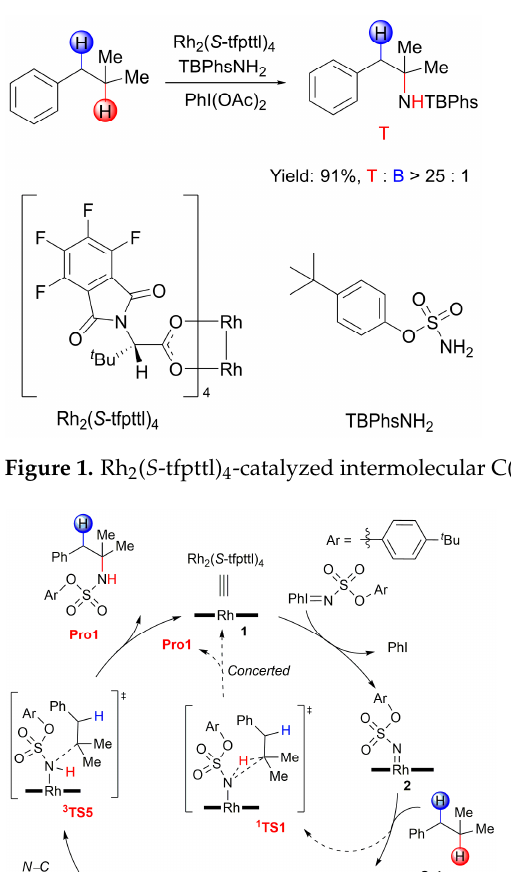
Figure 1. Rh 2 ( S -tfpttl) 4 -catalyzed intermolecular C( sp 3 ) − H amination of isobutylbenzene.